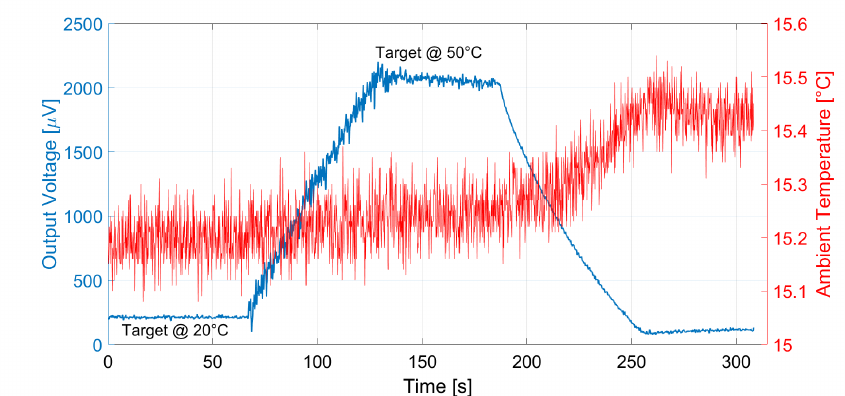
Figure 12. Measured thermopile E2 output with the black body at 10 cm distance and ambient temperature equal to 15 ◦ C. The black body temperature was varied as a ramp from 20 to 50 ◦ C.